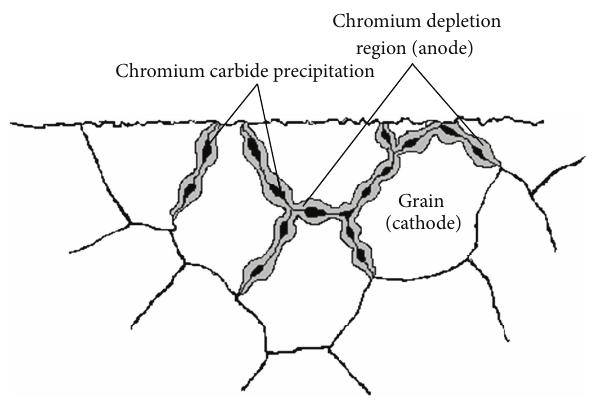
Figure 10: Schematic representation of precipitation of chromium carbide ( Fe , Cr ) 23 C 6 at the grain boundaries during sensitization in stainless